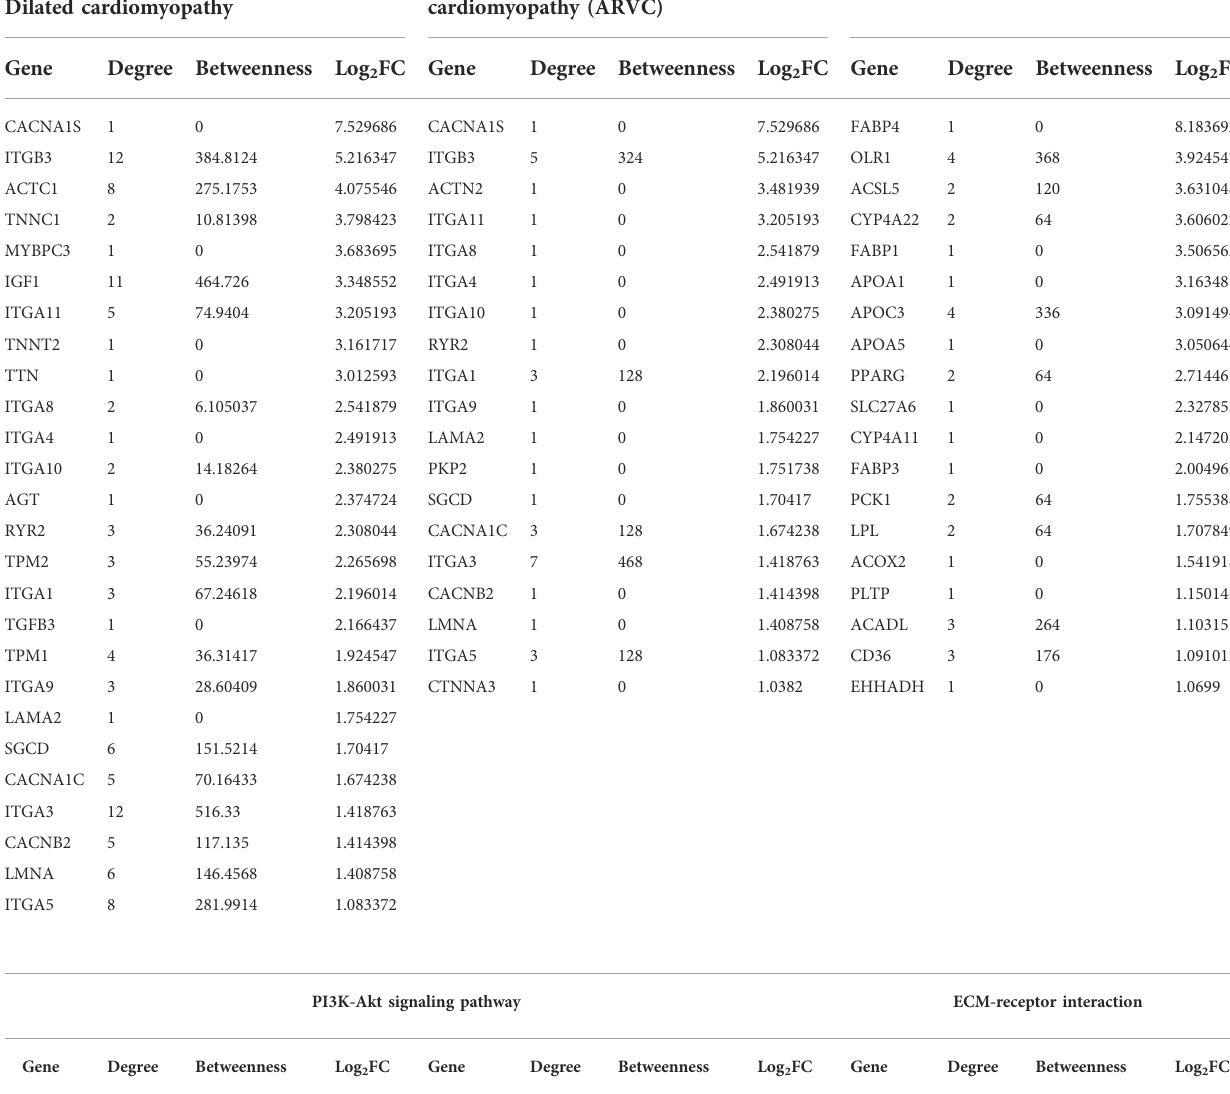
TABLE 5 List of genes identi fi ed for the selected KEGG pathways from Table 4, based on the upregulated DEGs in DMD-COs. Hypertrophic cardiomyopathy (HCM) or Dilated